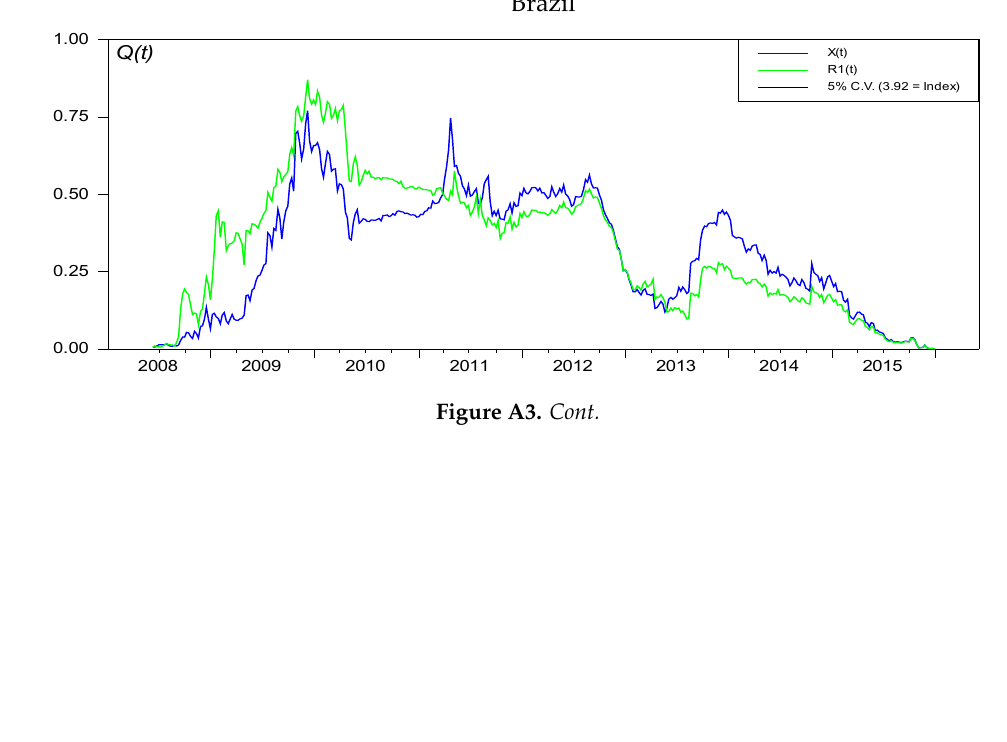
Figure A2. Trace Test Statistics. Note: "X-representation" denotes that all parameters of the cointegrated VAR system are re-estimated during the recursions, while under the "R-representation", only the long-run parameters are re-estimated. The graphs are scaled by the 5% critical value and we accept the null hypothesis that the chosen rank is maintained if it takes values greater than one, regardless of the sub-period it has been estimated for.